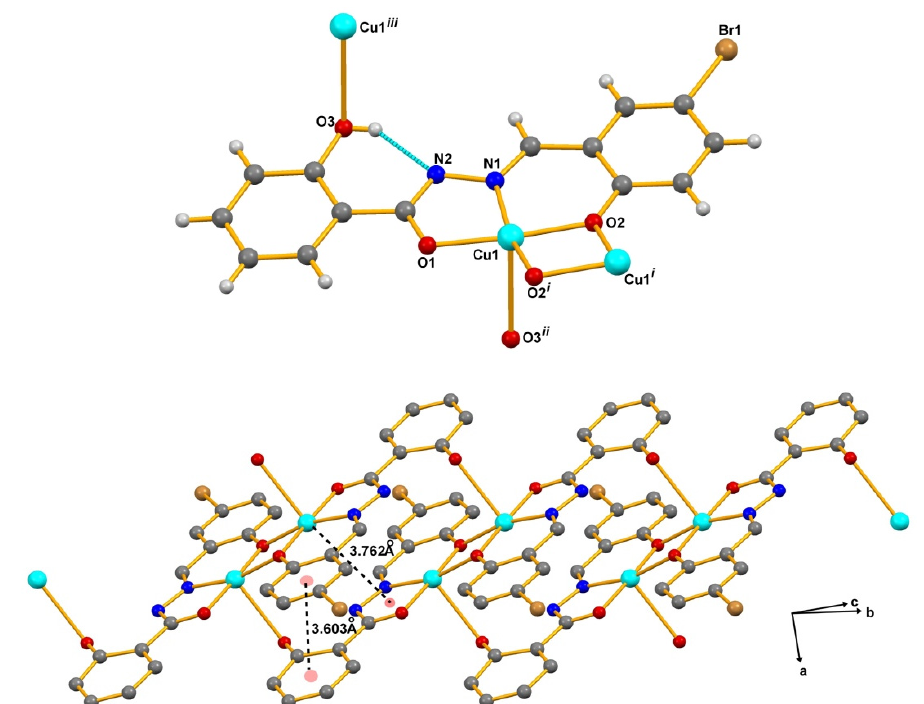
Figure 1. Structural representation of 1 with partial atom labeling scheme ( top ). H-bond interactions are represented by the dashed light blue color. Symmetry codes to generate equivalent atoms are as follows: (i) 2 − x , 1 − y , 1 − z ; (ii) x , 1 + y , z ; (iii) x , − 1 + y , z . The infinite 1D chain of 1 runs along the crystallographic a axis ( bottom